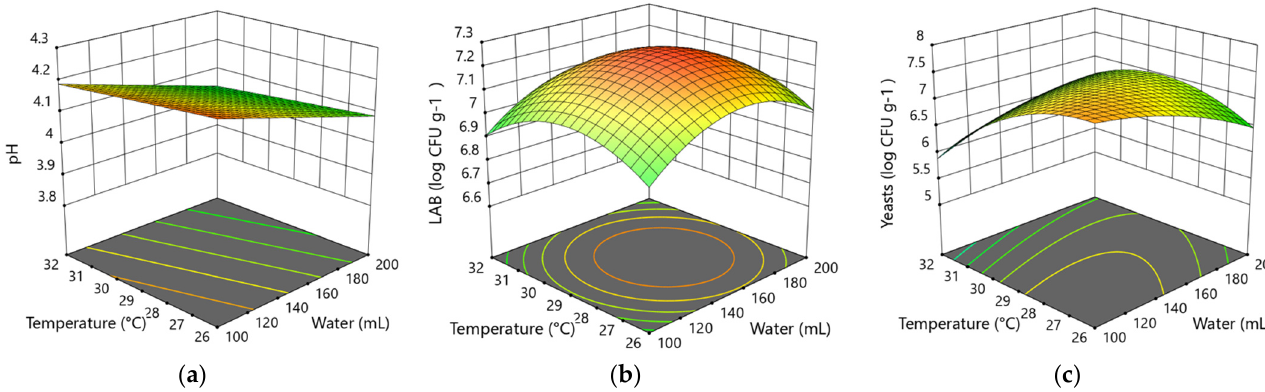
Figure 3. Response surface plots show the effect of temperature and water on pH ( a ), LAB ( b ) and yeasts ( c ) log CFU g − 1 in the 3rd backslopping step of fermentation at the actual factor (12 h).